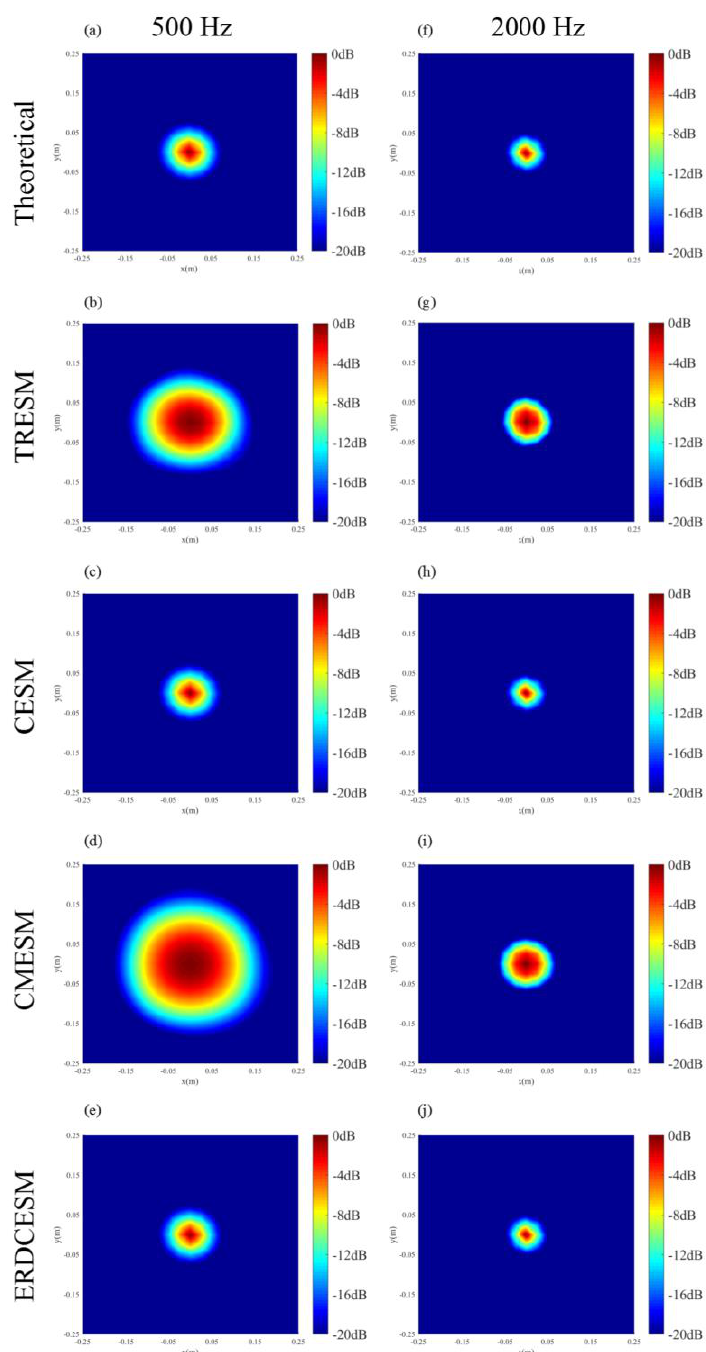
Figure 4. The calculated sound maps of ( a ) Theoretical map at 500 Hz, ( b ) TRESM map at 500 Hz, ( c ) CESM map at 500 Hz, ( d ) CMESM map at 500 Hz, ( e ) ERDCESM map at 500 Hz, ( f ) Theoretical map at 2000 Hz, ( g ) TRESM map at 2000 Hz, ( h ) CESM map at 2000 Hz, ( i ) CMESM map at 2000 Hz and ( j ) ERDCESM map at 2000 Hz for a single source.